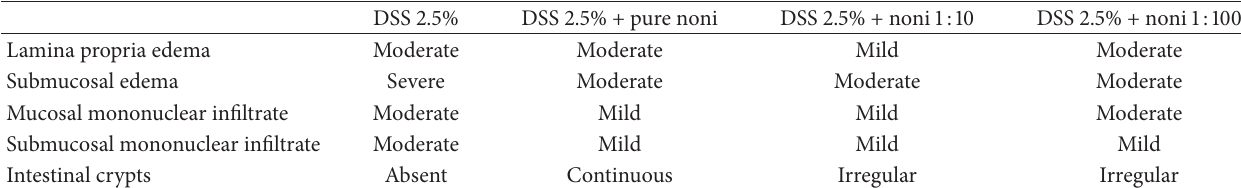
Figure 2: Noni fruit juice consumption preserves intestinal architecture in a dose-dependent manner. C57BL/6 mice were exposed to dextran sulfate sodium (DSS) 2.5% and treated daily with noni fruit juice. The colon was collected on day 9 for histopathological analysis. (a) Healthy mice without colitis; (b) mice exposed to DSS: lamina propria with moderate edema and mononuclear cell infiltration (arrowhead), submucosa with moderate mononuclear infiltrate and severe edema (arrow); (c) mice exposed to DSS and treated with pure noni fruit juice: lamina propria with moderate edema (arrow) and mononuclear infiltrate (arrowhead); (d) mice exposed to DSS and treated with noni fruit juice diluted 1: 10: crypts with preserved irregularities (asterisk); lamina propria with moderate edema (arrow) and mononuclear infiltrate (arrowhead); (e) mice exposed to DSS and treated with noni fruit juice diluted 1: 100: regular and atrophic crypts (asterisk); lamina propria with moderate edema (arrow) and mononuclear infiltrate (arrowhead). Table 1: Histopathological scores of mice exposed to DSS in different